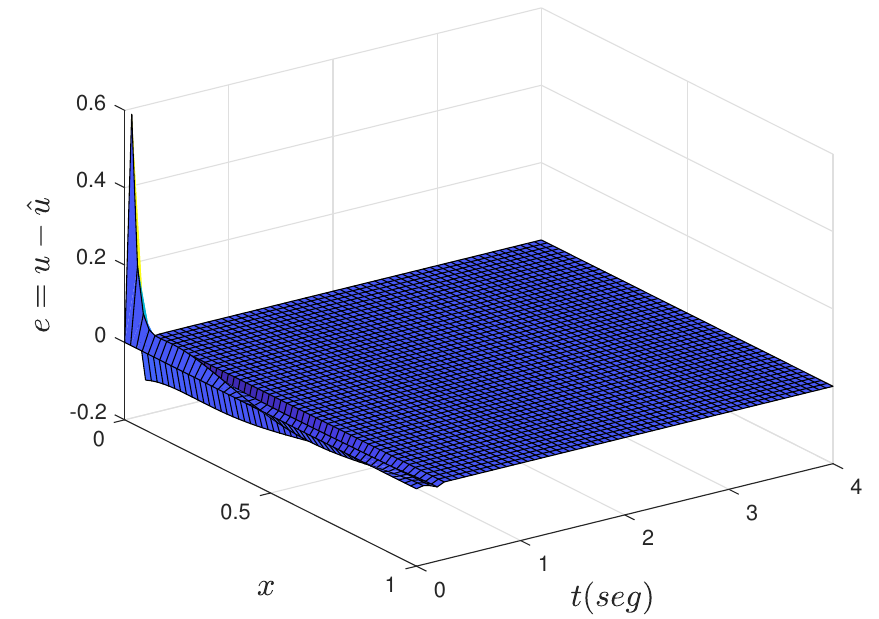
Figure 10. Dynamics of the estimation error.